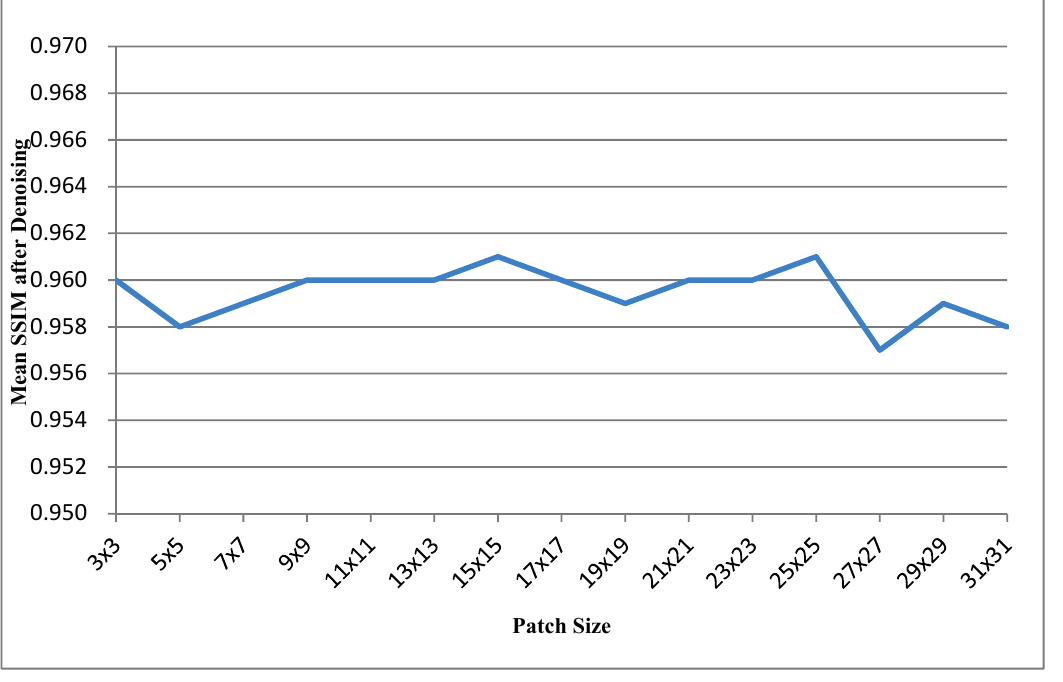
Figure 6. Curve of average of mean SSIMs after denoising vs. patch